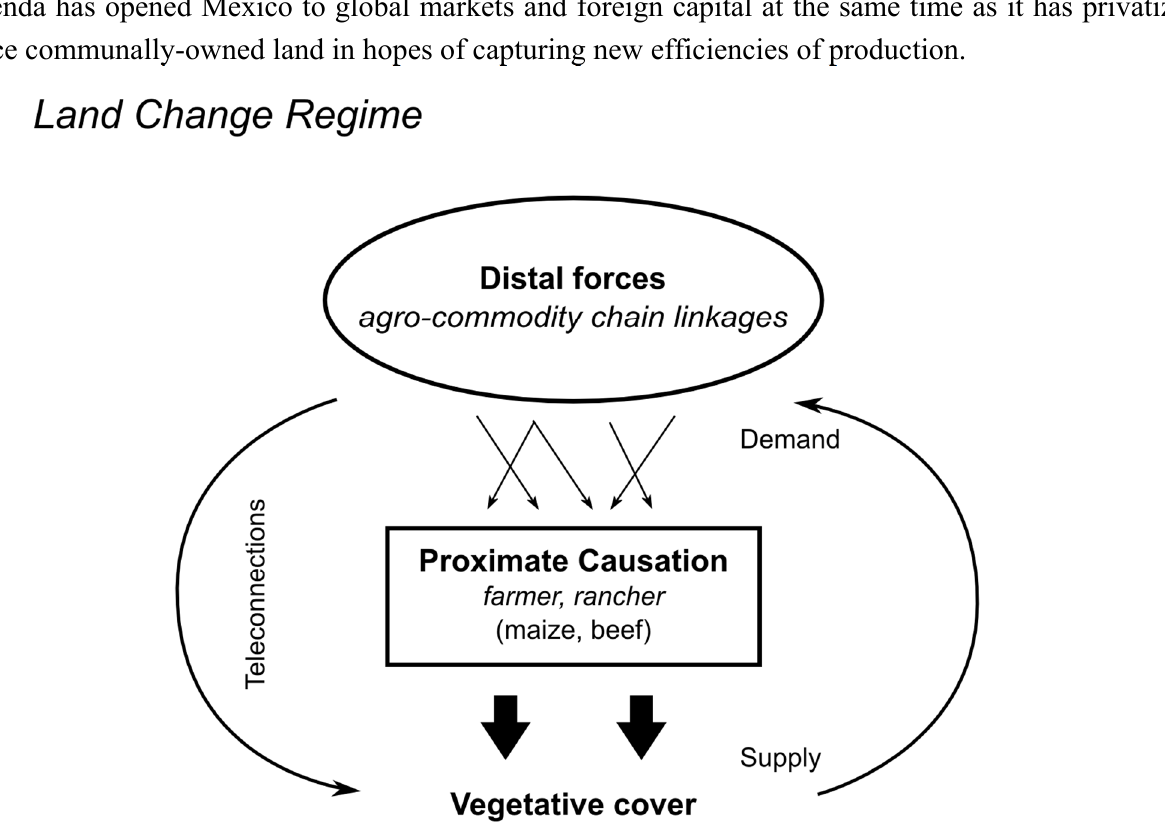
Figure 1. Conceptualization of Mexico’s Land Change